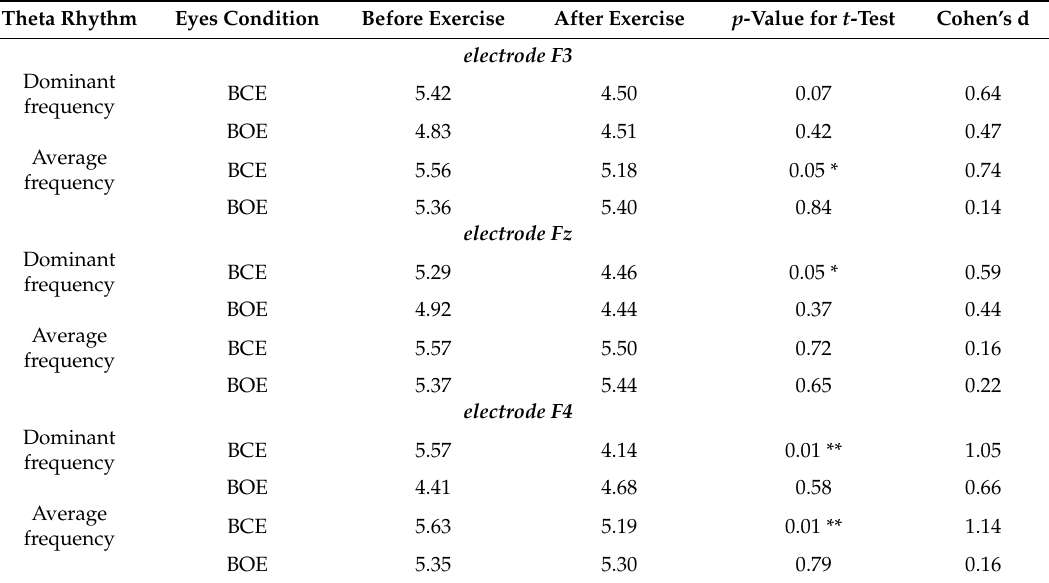
Table 3. Dynamics of theta rhythm before and after